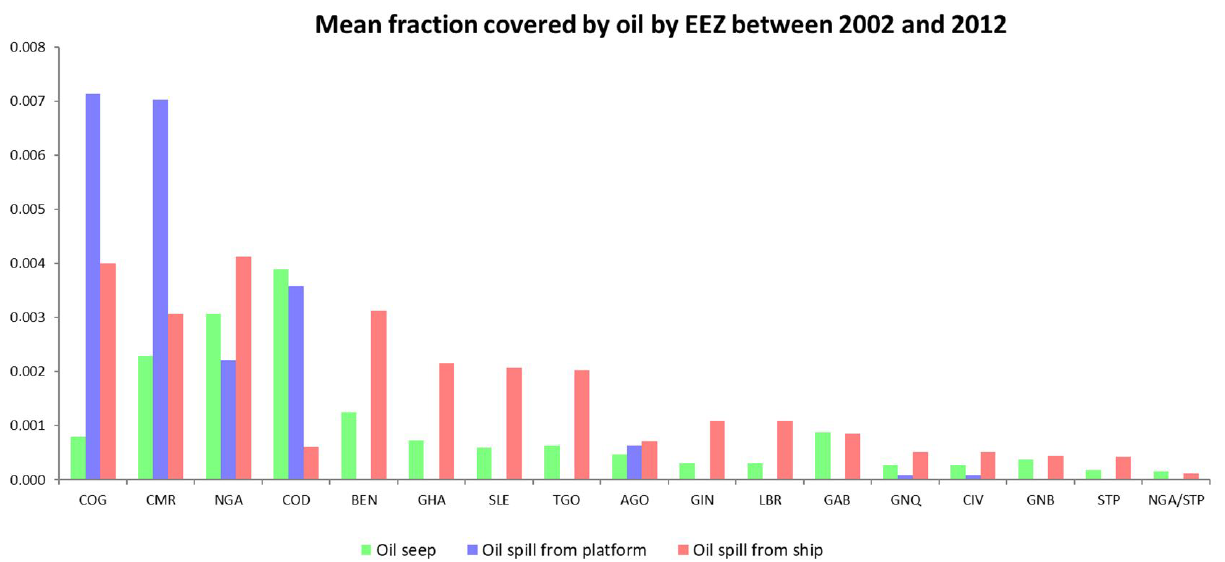
Figure 18. Mean fraction covered by spilled oil by EEZ between 2002 and 2012.